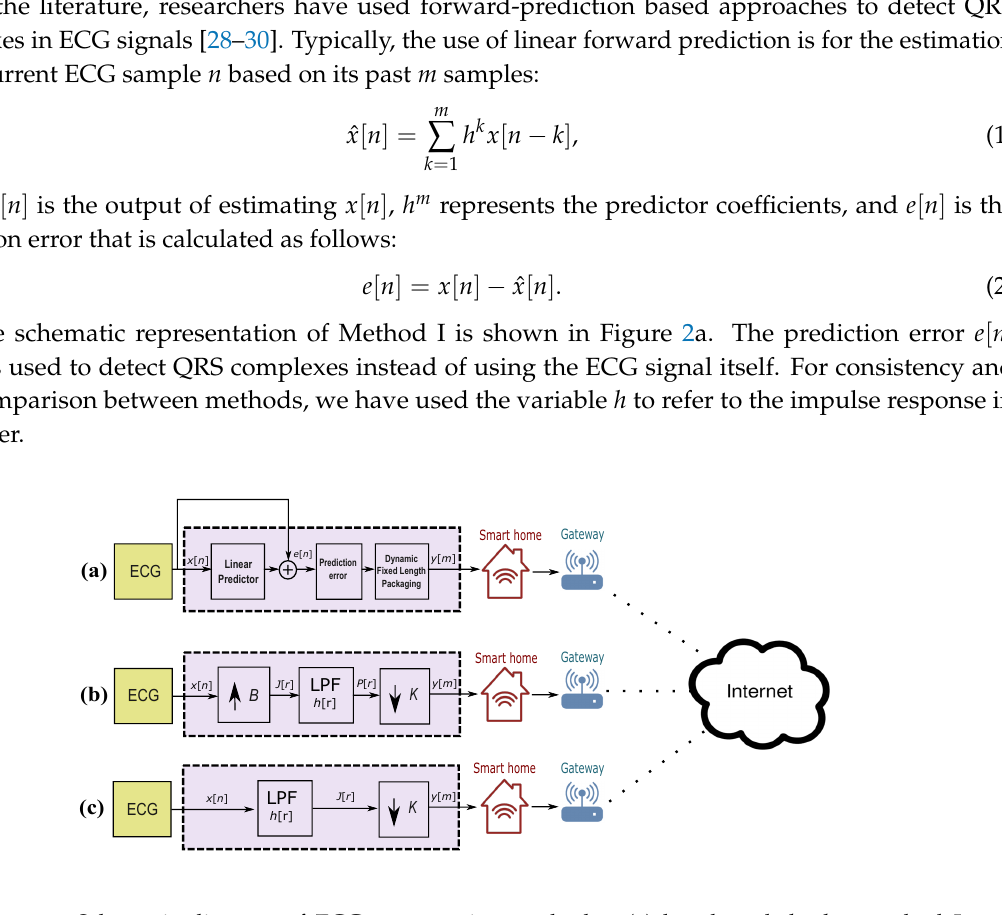
Figure 2. Schematic diagram of ECG compression methods. ( a ) benchmark lossless method I ( b ) benchmark lossy method II ( c ) proposed lossy method